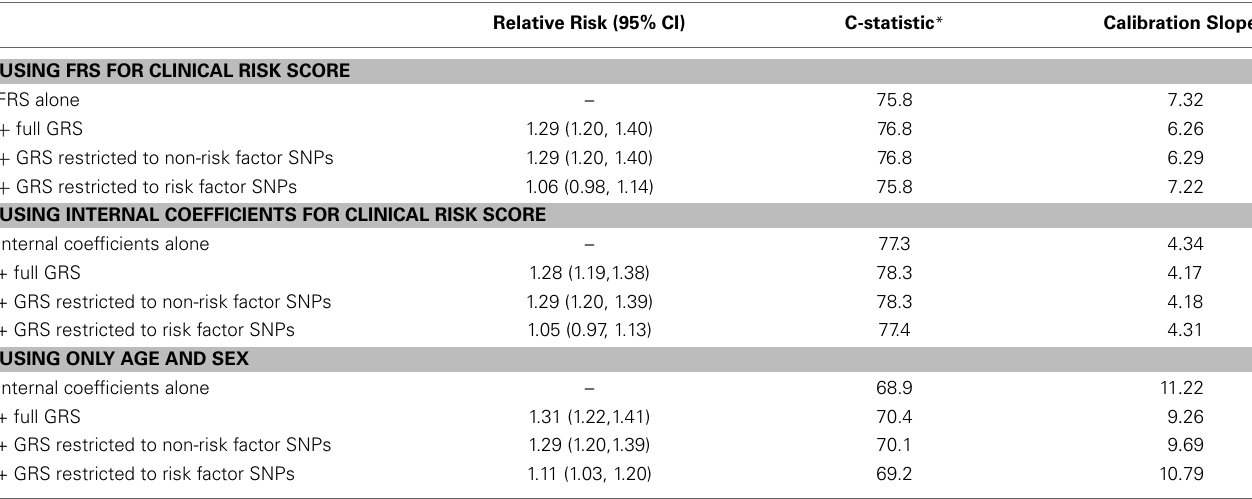
Table 2 | Relative Risks and discrimination metrics for a genetic risk score derived from 50 genome wide significant susceptibility alleles for CHD in the full ARIC sample ( n = 8491) of white/Europeans